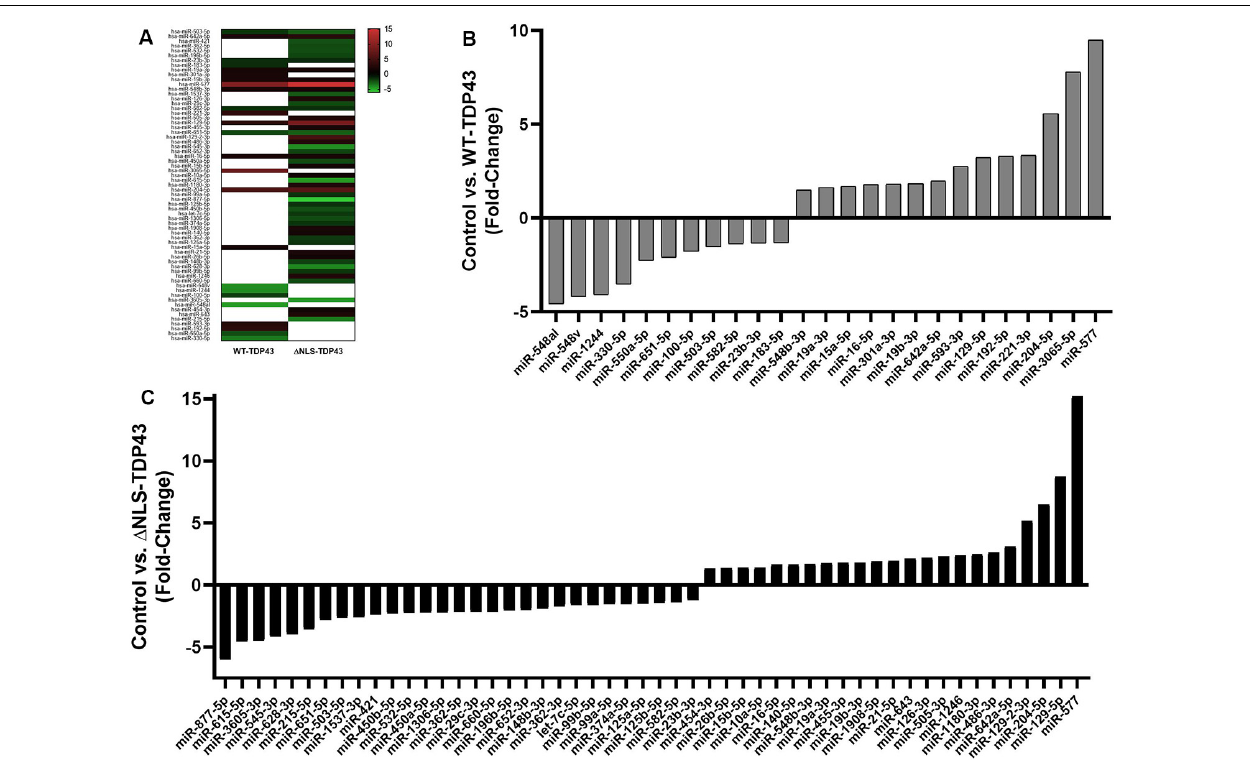
FIGURE 3 | Enriched miRNAs associated with cyTDP43. miRNAs in the cytoplasmic fractions of the control (eGFP-His), WT-TDP43-eGFP-His (WT-TDP43), and ∆ NLS-TDP43-eGFP-His ( ∆ NLS-TDP43) stable cell lines were profiled using NanoString technology. Each individual miRNA was normalized to the top 100 miRNAs and fold-change was determined relative to the control line; n = 4 per line. (A) Heat map of the fold-change of the top enriched miRNAs. Red represents positive values (increased enrichment), while green represents negative values (decreased enrichment) for the WT-TDP43 (left) and ∆ NLS-TDP43 (right) lines relative to the control (eGFP-His) line. (B,C) Fold change of top enriched miRNAs in the cytoplasmic fraction of the WT-TDP43 (B) and ∆ NLS-TDP43 (C)